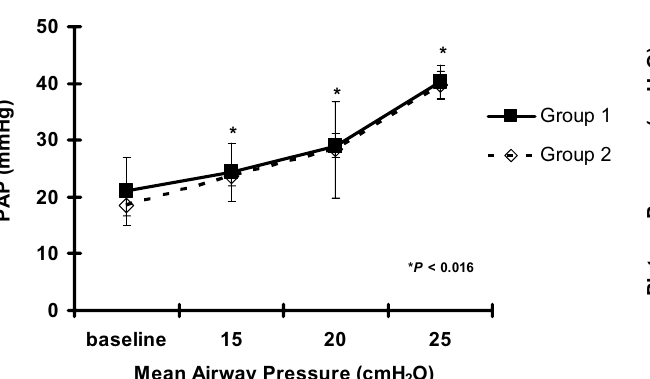
FIGURE 4 - Plateau Pressure: MAP 25cmH O and 20cmH O were compared increase of Ppl ( P 2 2 O in both groups ( P =0.016 2